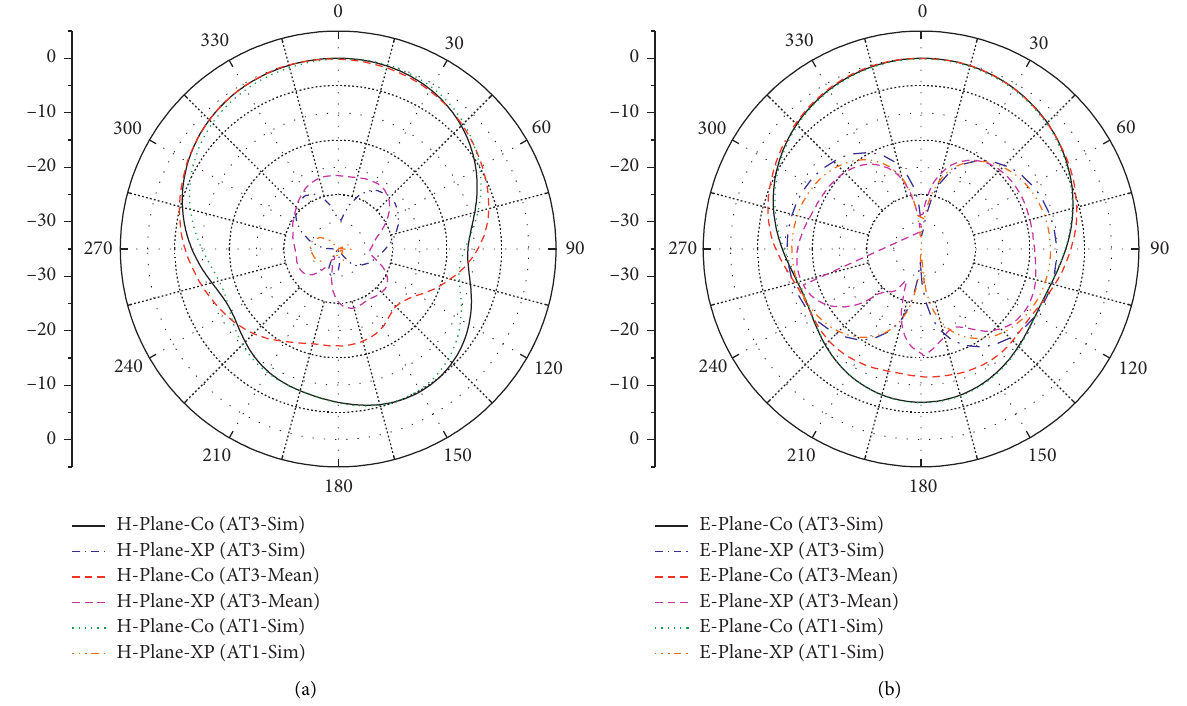
Figure 13: Simulated and measured far-field radiation patterns: (a) H plane; (b) E plane.